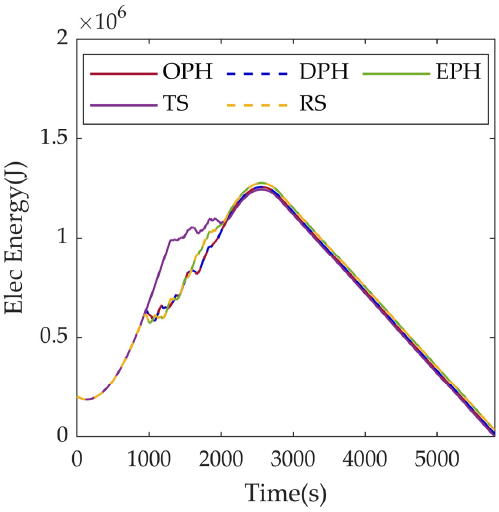
Remote Sens. 2023 , 14 , x FOR PEER REVIEW 23 of 30 Figure 16. Satellite electrical energy diagram of a single condition in the third group. Figure 16. Satellite electrical energy diagram of a single condition in the third group. Figure 16. Satellite electrical energy diagram of a single condition in the third group.